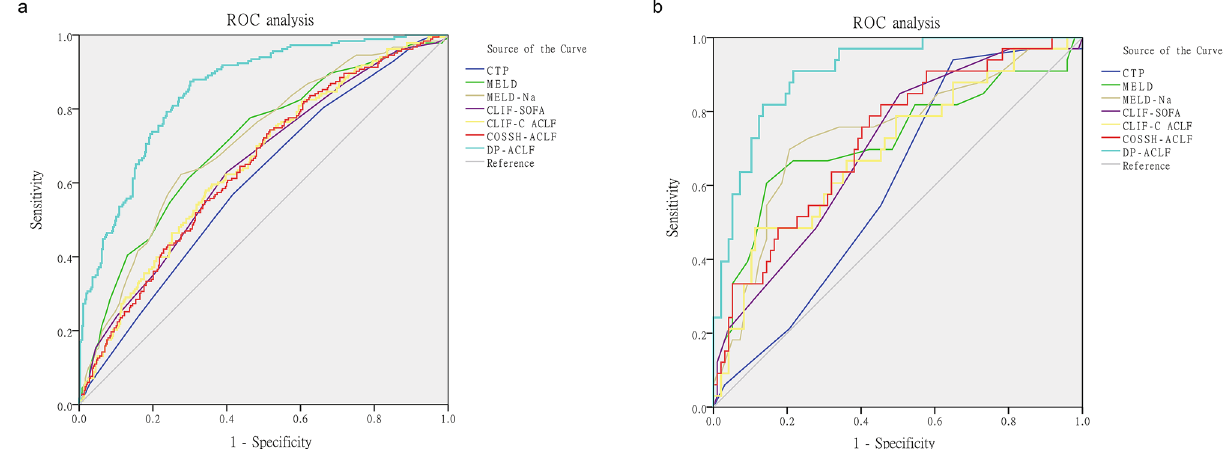
Figure 5. The DP-ACLF score was compared with the baseline data of other prognostic scoring systems, and ROC curves were performed to determine prognostic accuracy. ( a ) Training group. ( b ) Validation group.